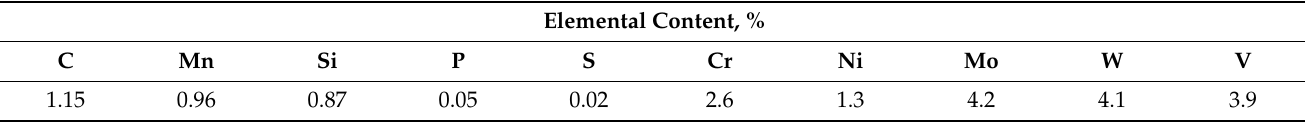
Table 1. Chemical composition of the tested HSS